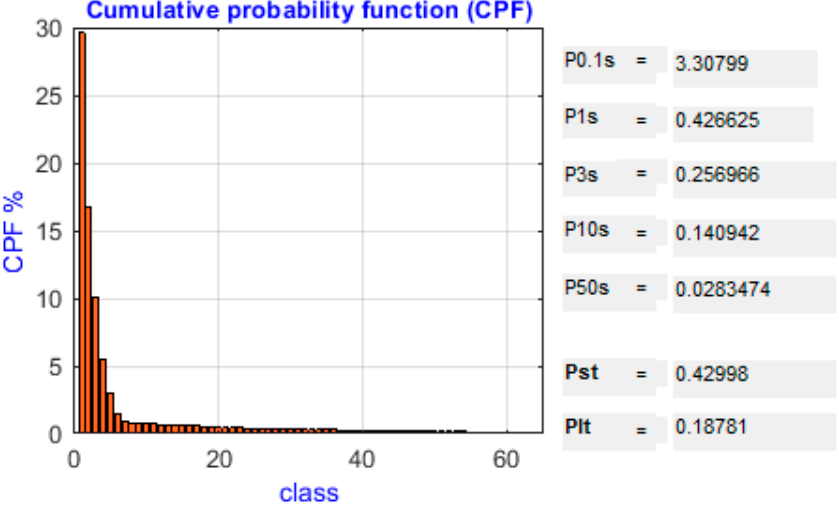
Figure 12. Long- and short-term flicker severity assessments and calculation.